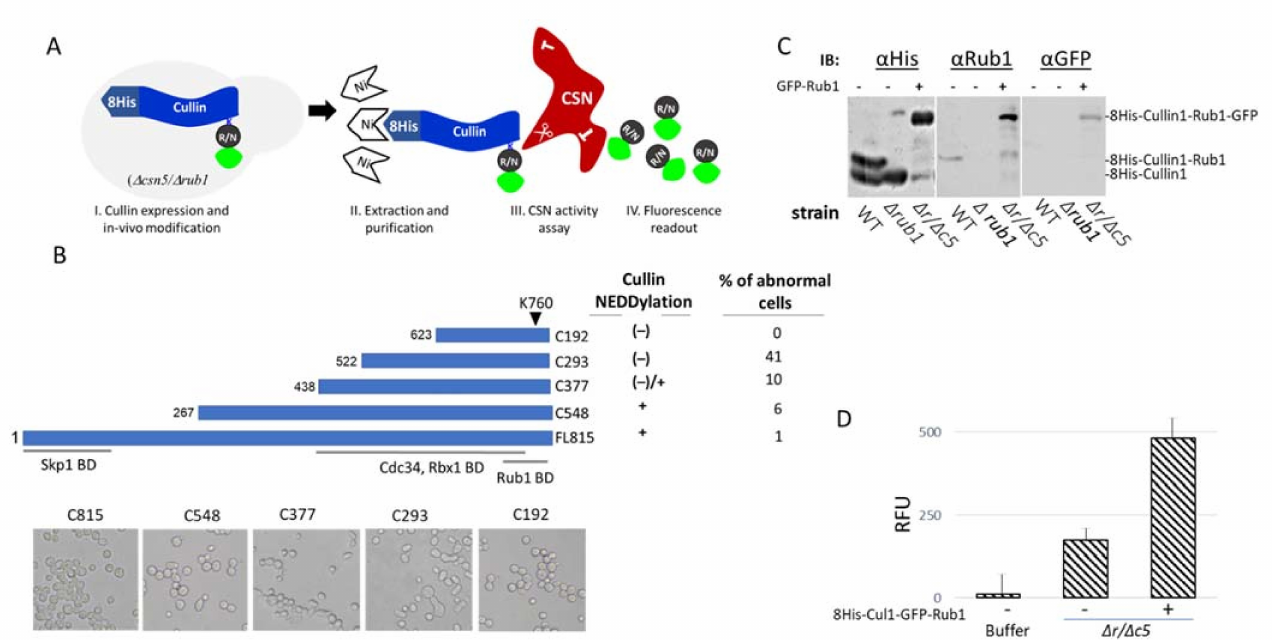
Figure 3. Designing a general substrate for a CSN cullin deneddylase readout assay. ( A ) Assay scheme: 8His-Cullin (yCul1) and GFP-Rub1/Nedd8 (R/N) are overexpressed in ∆ csn5 ∆ rub1 mutant cells, and become covalently attached to each other through the endogenous neddylation cascade of enzymes. Next, the 8His-yCul1-GFP-Rub1 conjugates (e.g., substrate) are affinity purified through Ni-NTA resin. These substrates are added to CSN or CSN-containing extracts (e.g., enzyme), which eventually cause the hydrolysis of GFP-Rub1 (e.g., product) that is collected for fluorescence evaluation. ( B ) Various mutants of yCul1, all of which bear the neddylation specific residue (K760) and an N-terminal 8His tag. Terminology is according to the number of amino acids in each of the mutants. Rub1, Rbx1, and Skp1 binding domains (BD) are illustrated at the bottom. The ability of each yCul1 form to be modified by Rub1 (neddylation) is indicated by + or ( − ). Transformant ∆ csn5 ∆ Rub1 mutant cells bearing the yCul1 truncations were collected directly from the agar plates and cell morphology was examined by light microscopy. Cells with abnormal morphology (enlarged or elongated) were counted, and the percentage of cells showing atypical morphology was summarized (top, right) or shown (bottom). ( C ) The ability of endogenous neddylation enzyme to modify 8His-yCul1 by GFP-Rub1 was evaluated. Wildtype (wt) ∆ rub1 and ∆ csn5 ∆ rub1 ( ∆ r/ ∆ 5) expressing the fluorogenic substrate were grown in selective medium. Neddylation of the full length 8His-yCul1 (FL815) was analyzed by immunoblotting with antibodies for yCul1, 6His, and GFP. ( D ) Native protein extracts were linked to Ni-NTA resin, eluted, and fluorescent readout was detected by a plate-reader and counted in “relative fluorescent units” (RFU). Notably, cells expressing FL815 and GFP-Rub1 show high fluorescence values compared to naïve cells or buffer